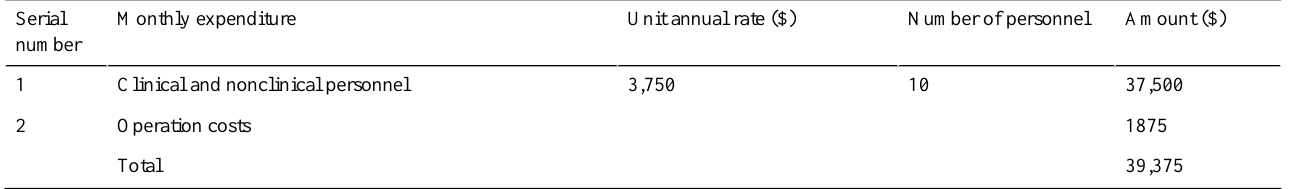
Table 7. Personnel and operation expenditure of a primary health center a .